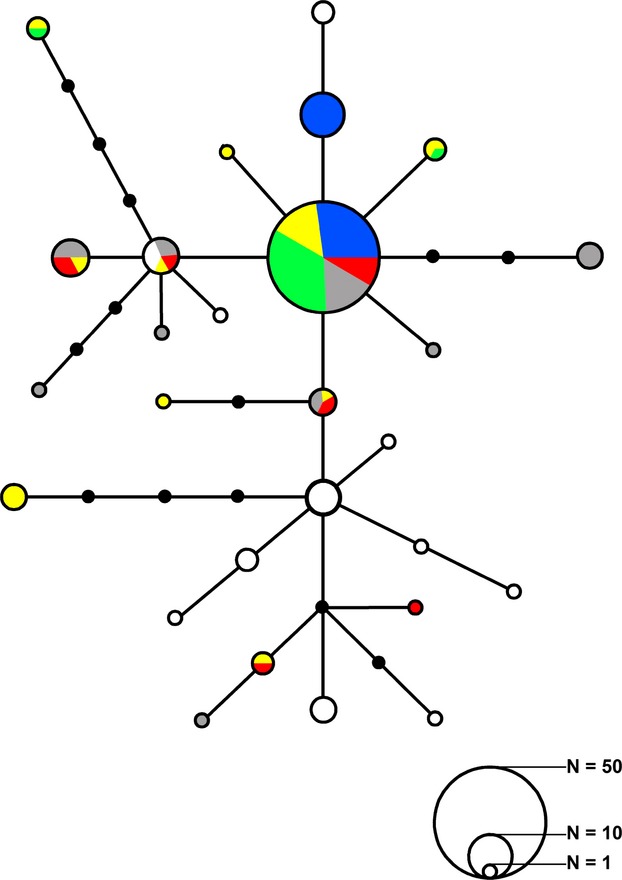
Median-joining network of mtCR haplotypes for Mustelus henlei. Circles represent individual haplotypes with size proportional to frequency, branches indicate mutations, and black circles are hypothetical ancestors. Localities are as follows: San Francisco Bay (Blue), Santa Barbara (Yellow), Santa Catalina Island (Green), Punta Lobos (Gray), San Felipe (Red), and Costa Rica (White). Numbers of samples per circle size are represented at bottom right.